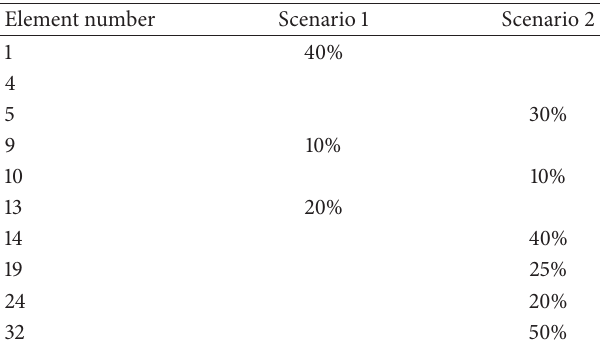
Table 8: Simulated damage scenarios in unbraced plane